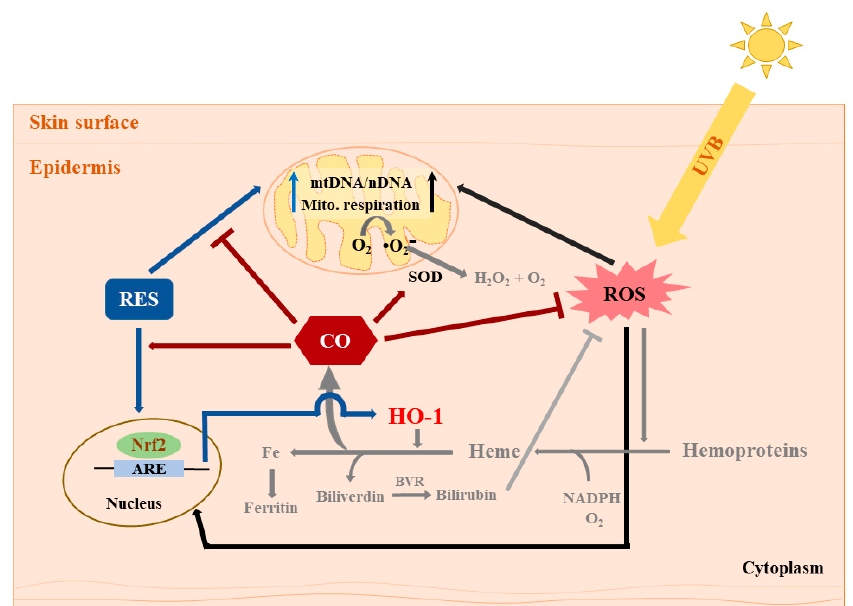
Figure 4. Summary of the e ff ects of RES and CORM-2 on UVB-irradiated HaCaT cells. RES and / or CORM-2 promoted adaptive response under oxidative conditions through modulation of mitochondrial function and antioxidant enzyme signaling in HaCaT cells. Although the e ff ect of RES on HO-1-derived CO could not be directly confirmed, this study was able to provide initial evidence regarding the participation of intracellular CO in cellular regulation against UVB-induced cytotoxicity. Pathways colored in grey indicate that the processes may possibly take place outside the cell. ARE: antioxidant response element, BVR: biliverdin reductase, CO: carbon monoxide, HO-1: heme oxygenase 1, mtDNA: mitochondrial DNA, nDNA: nuclear DNA, Nrf2: nuclear factor erythroid 2-related factor 2, RES: resveratrol, ROS: reactive oxygen species, SOD: superoxide dismutase, UVB: ultraviolet light B. Supplementary Materials: The following are available online at http: // www.mdpi.com / 2076-3921 / 8 / 10 / 432 / s1, Figure S1: Hypothetical mechanism for the cytoprotective e ff ect of RES and CORM-2 under oxidative conditions. The current work highlights the role of intracellular CO in maintaining cellular homeostasis by upregulating the stress-inducible antioxidant enzymes to enhance cellular detoxification and ultimately maintaining redox balance in HaCaT cells. CO: carbon monoxide, CORM-2: CO-releasing molecule-2, HO-1: heme oxygenase-1, RES: resveratrol, ROS: reactive oxygen species, Figure S2: Viability of HaCaT cells treated with various concentrations of CORM-2. As concentrations above 100 µ M CORM-2 were found to be cytotoxic to HaCaT cells, 100 µ M was selected as the suitable treatment concentration for this study. In addition, non-cytotoxic concentrations of RES and SnPP were used consistently in this study. Cells were incubated with RES, CORM-2, or SnPP for 24 h and cytotoxicity was measured by CCK-8 assay. Results represent mean ± SD ( n = 3). Bars not sharing common letters indicate significant di ff erences ( p < 0.05), as evaluated using one-way ANOVA followed by the Duncan multiple-range test. Control, DMSO; RES, resveratrol; CORM-2, CO-releasing molecule-2, SnPP, tin protoporphyrin IX., Figure S3: Viability of H 2 O 2 -exposed HaCaT cells pre-treated with RES and / or CORM-2. CORM-2 and RES increased the viability of HaCaT cells exposed to H 2 O 2 -induced cytotoxicity. Thus, RES and CORM-2 exhibit cytoprotective e ff ect against H 2 O 2 -induced oxidative damage. Cells were pre-treated with RES, CORM-2, and / or SnPP and then exposed to H 2 O 2 . Results represent mean ± SD ( n = 3). Bars not sharing common letters indicate significant di ff erences ( p < 0.05), as evaluated using one-way ANOVA followed by the Duncan multiple-range test. Control, DMSO; RES, resveratrol (30 µ M); CORM-2, CO-releasing molecule-2 (100 µ M), SnPP, tin protoporphyrin IX (10 µ